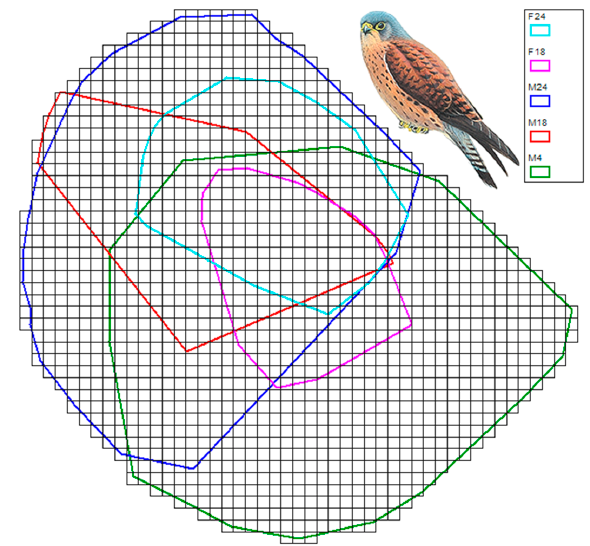
Figure 2. Tessellation (1584 squares) of the smallest possible convex polygon around the 2D home ranges (coloured polygons) of the tracked lesser kestrels. IDs are the same as those in Table 1.